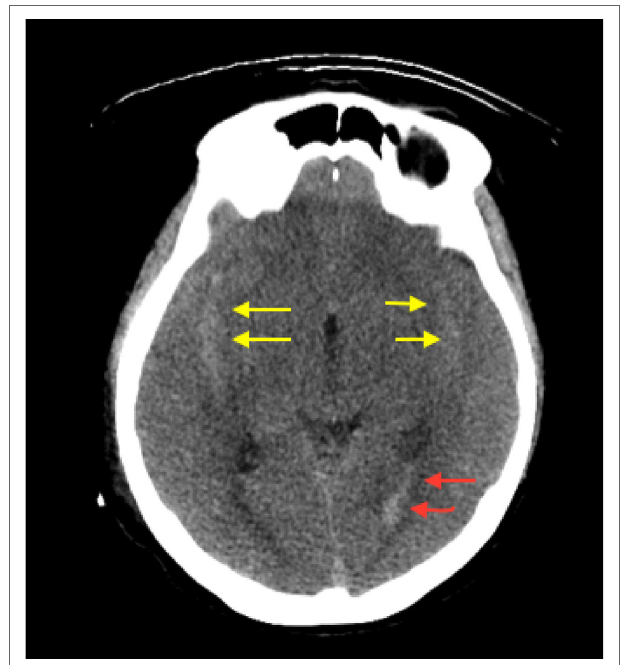
FIguRe 1 | Axial section CT demonstrating diffuse brain edema evident by effacement of cortical sulci and the subarachnoid hemorrhage in both Sylvian fissures (yellow arrows) with seeding into the ventricular system (red